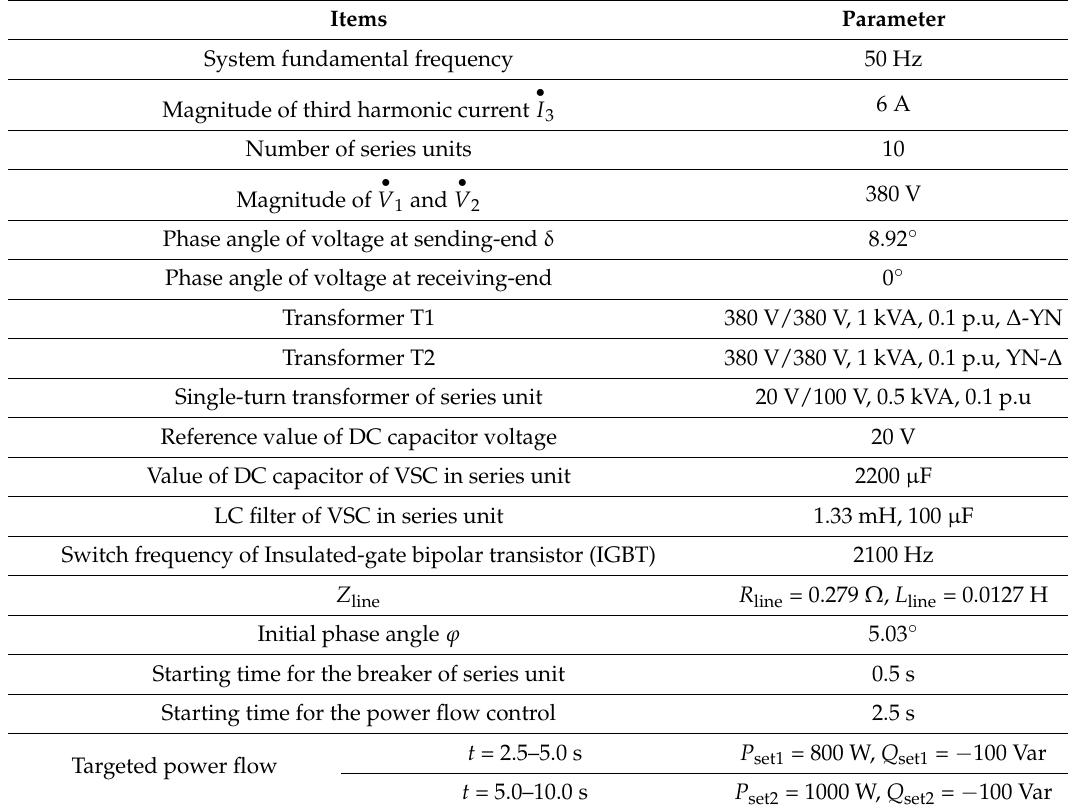
Table 1. DPFC device parameters.